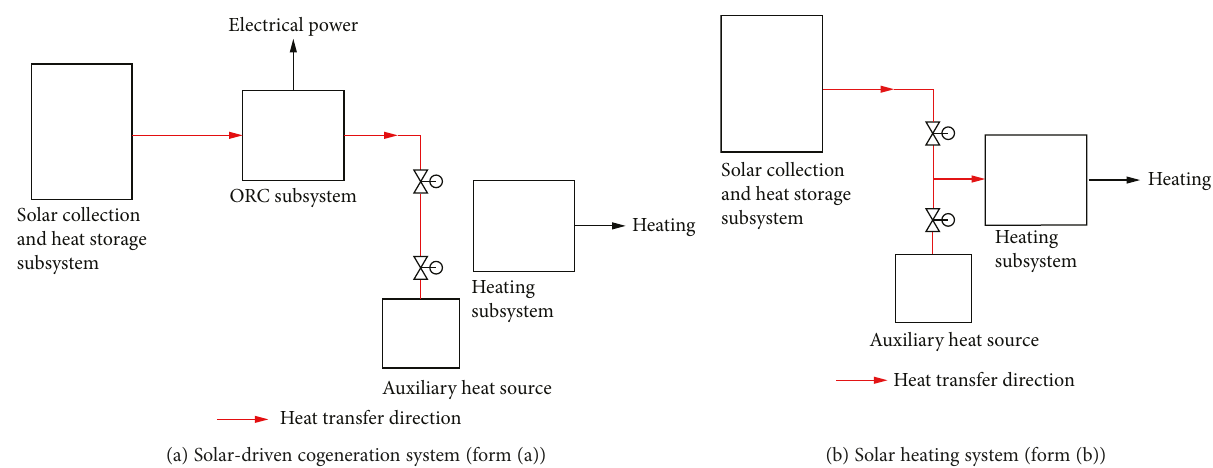
Figure 1: Forms when the building heating load is greater than the e ff ective heat collection.